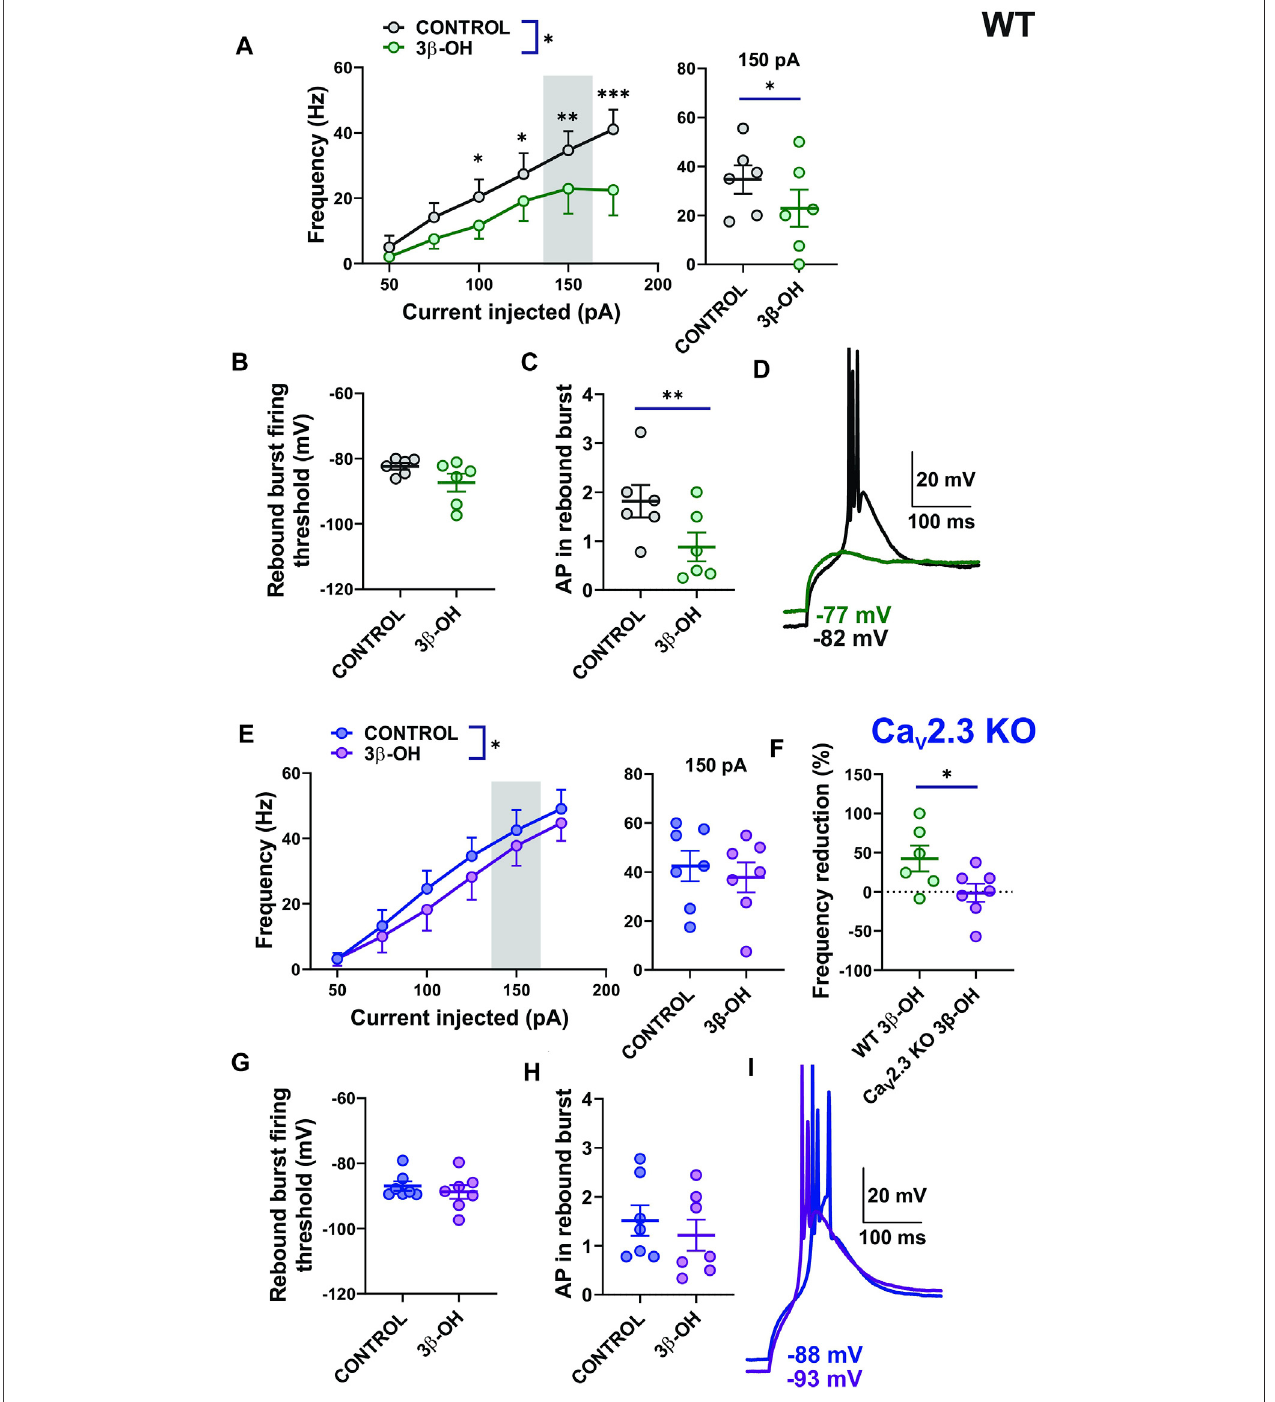
FIGURE 3 | Stimulated tonic and rebound burst fi ring of CMT neurons were reduced in the WT group more profoundly than in the Ca V 2.3 KO animals during the applicationof3 β -OH. (A) Averagestimulatedtonicfrequency fi ringbefore(black)andduringtheapplicationof3 μ M3 β -OH(green)acrossdifferentcurrentinjectionlevels (50 – 175 pA) in thalamic slices from WT animals ( n = 6, two-way RM ANOVA: interaction F 5,25 = 3.40, p = 0.018; 3 β -OH F 1,5 = 10.27, p = 0.024; current injection F 5,25 = 13.49, p < 0.001, Š ídák ’ smultiplecomparisonstestpresented),left;averagetonic fi ringfrequencyat150 pAcurrentinjectionextractedfromthesameexperiments ( n = 6, paired two-tailed t -test t 5 = 2.60, p = 0.048), right. (B) Rebound burst fi ring threshold after the hyperpolarization of the CMT neurons before and during the application of the neurosteroid in WT mice ( n = 6, paired two-tailed t -test, t 5 = 1.85, p = 0.124). (C) Average numbers of APs in rebound burst fi ring in control conditions and during the administration of 3 β -OH in WT mice ( n = 6, paired two-tailed t -test, t 5 = 5.38, p = 0.003). (D) Representative traces of rebound burst fi ring before (black)